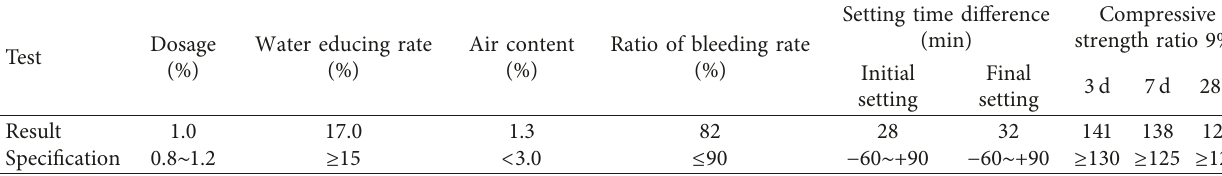
Table 3: Properties of water-reducing admixture.